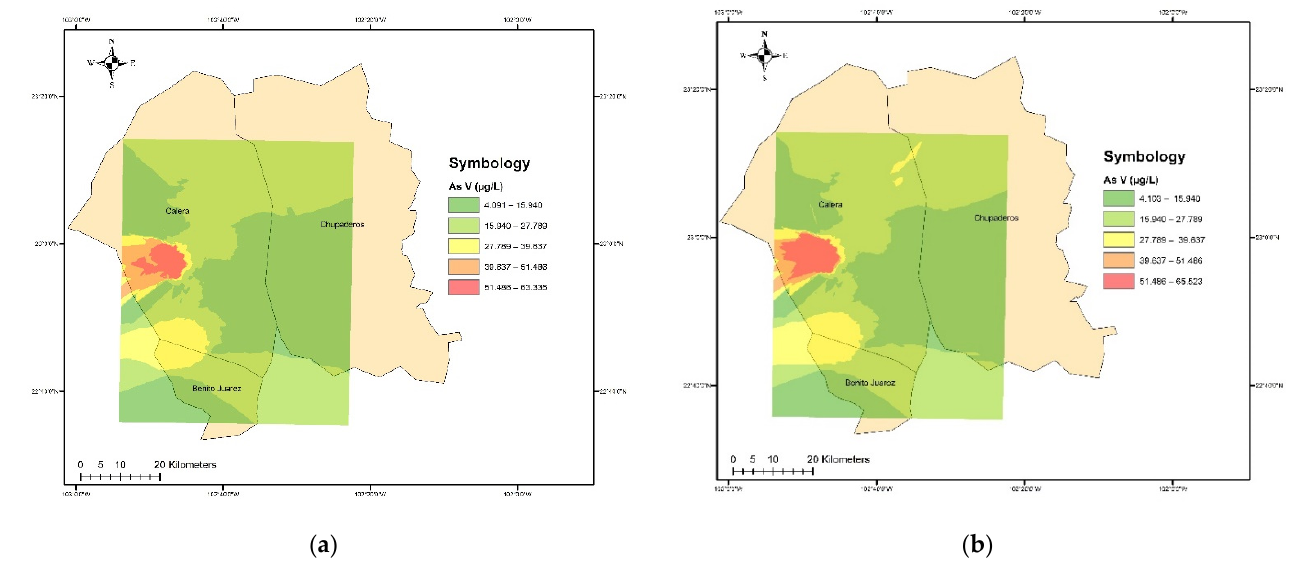
Figure 4. As (V) concentration in groundwater of the study area: ( a ) 2015; ( b ) 2020.